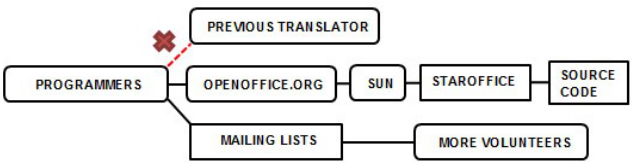
Fig. 4. Example of the rise of LibreOffice software.